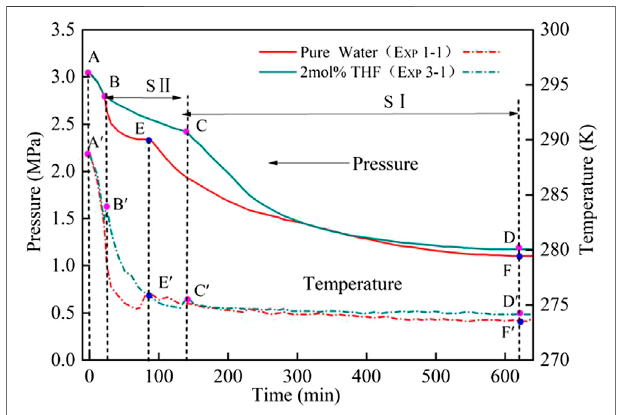
FIGURE 2 | Typical changes in p and T over time for CO 2 hydrate formation (2 mol% THF).